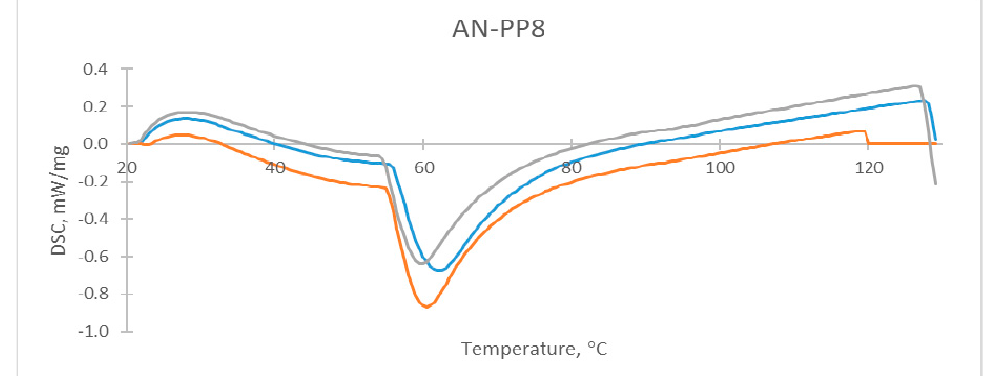
Figure 7. DSC results of AN-PP8.